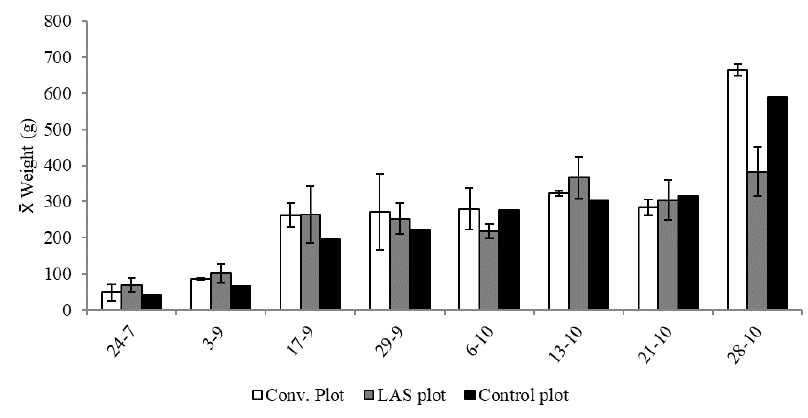
Figure 17. Weight of collected fruits from July to October in NO-LAS, LAS, and control plots.